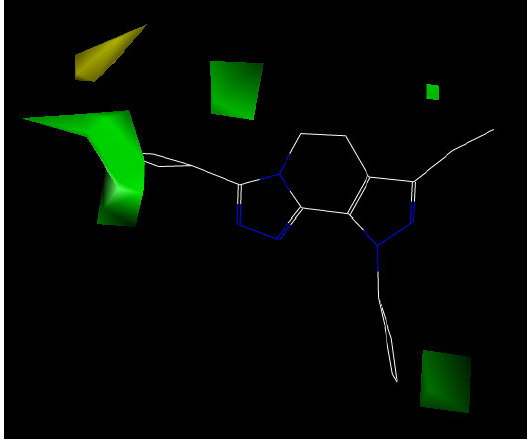
Figure 6. CoMFA contour maps of steric field with compound